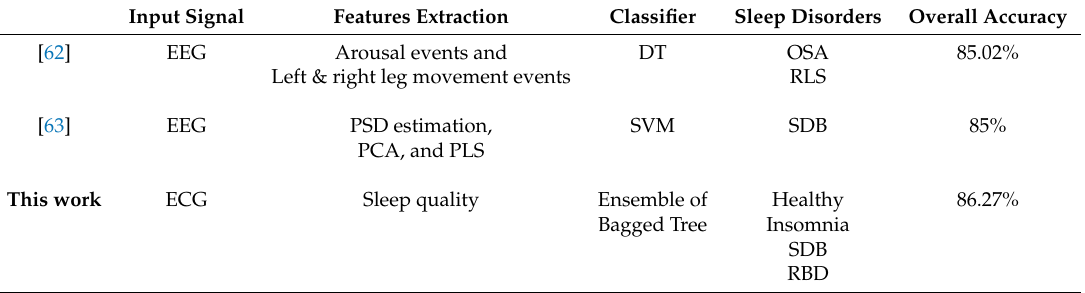
Table 10. Comparison